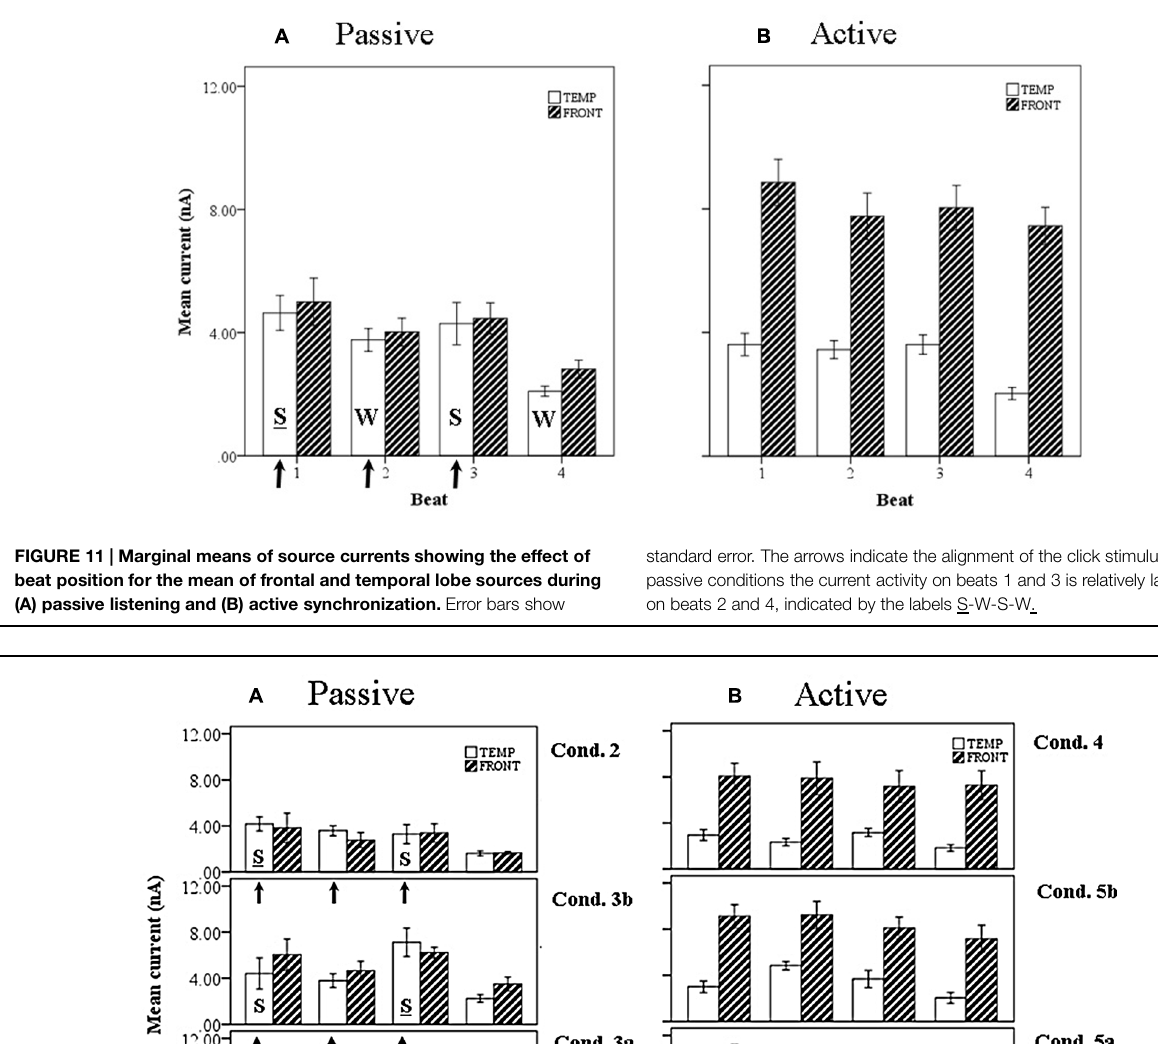
FIGURE 12 | Marginal means of source currents showing the effect of beat position for the mean of frontal and temporal lobe sources, broken down by syncopation condition, during (A) passive listening and (B) active synchronization. Error bars show SE. The arrows indicate the alignment of the click stimulus, with the